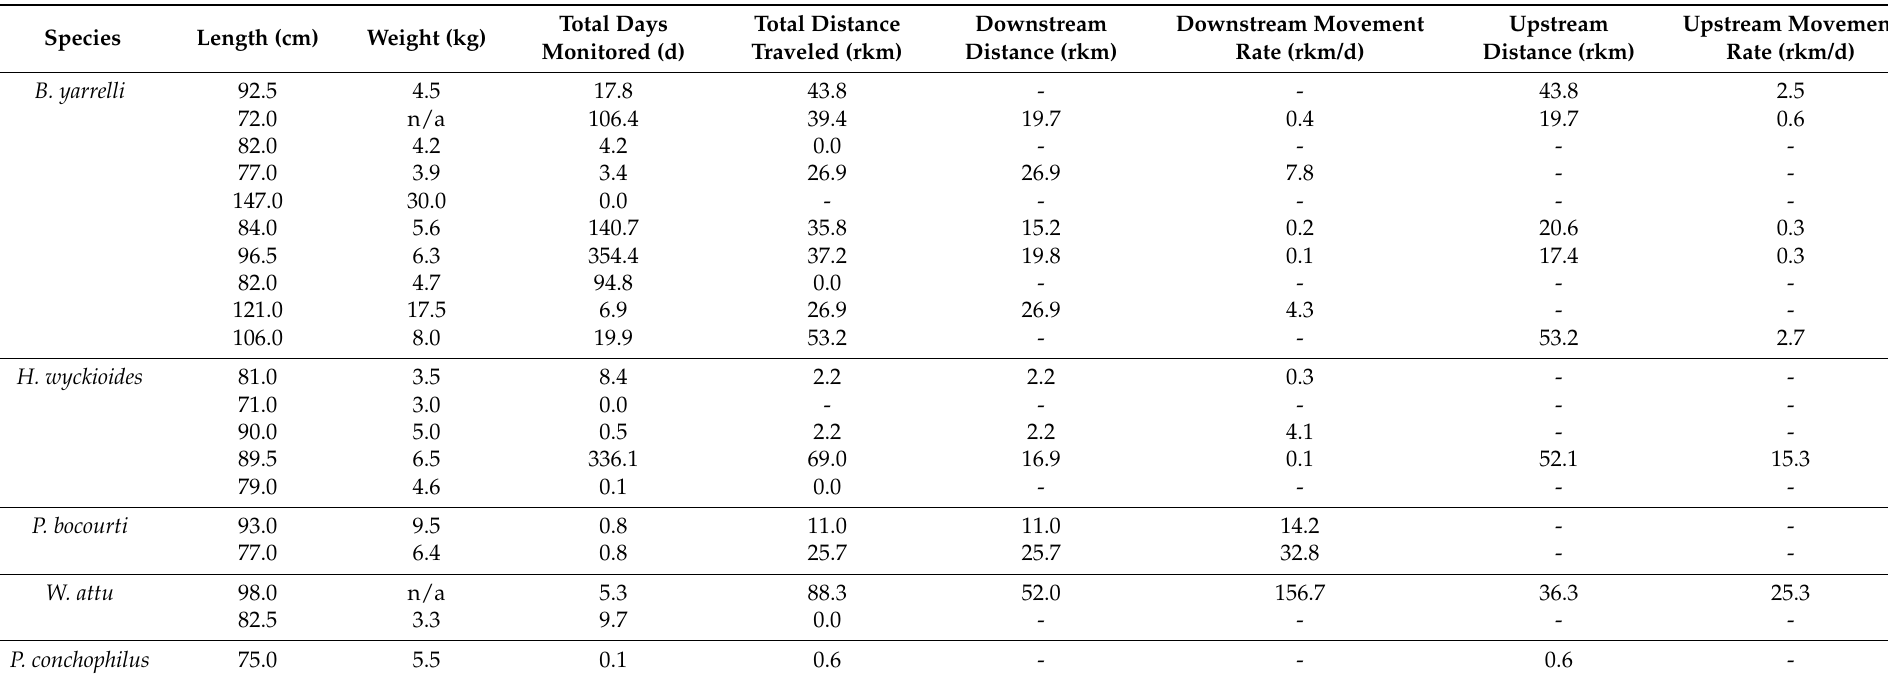
Table 4. Movement distances and rates of wild catfishes monitored in the Mekong River, northern Thailand and Lao PDR between May 2006 and May 2007. The first five columns are repeated from Table 3 for